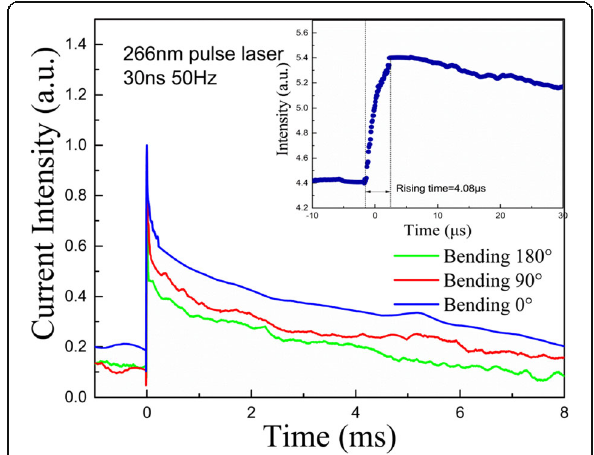
Fig. 8 The responsive time of ZnO MW array UV PD device for 266 nm pulsed laser illumination for 30 ns at a frequency of 50 Hz under a bias of 10 V at different bending angles (0°, 90°, and 180°)